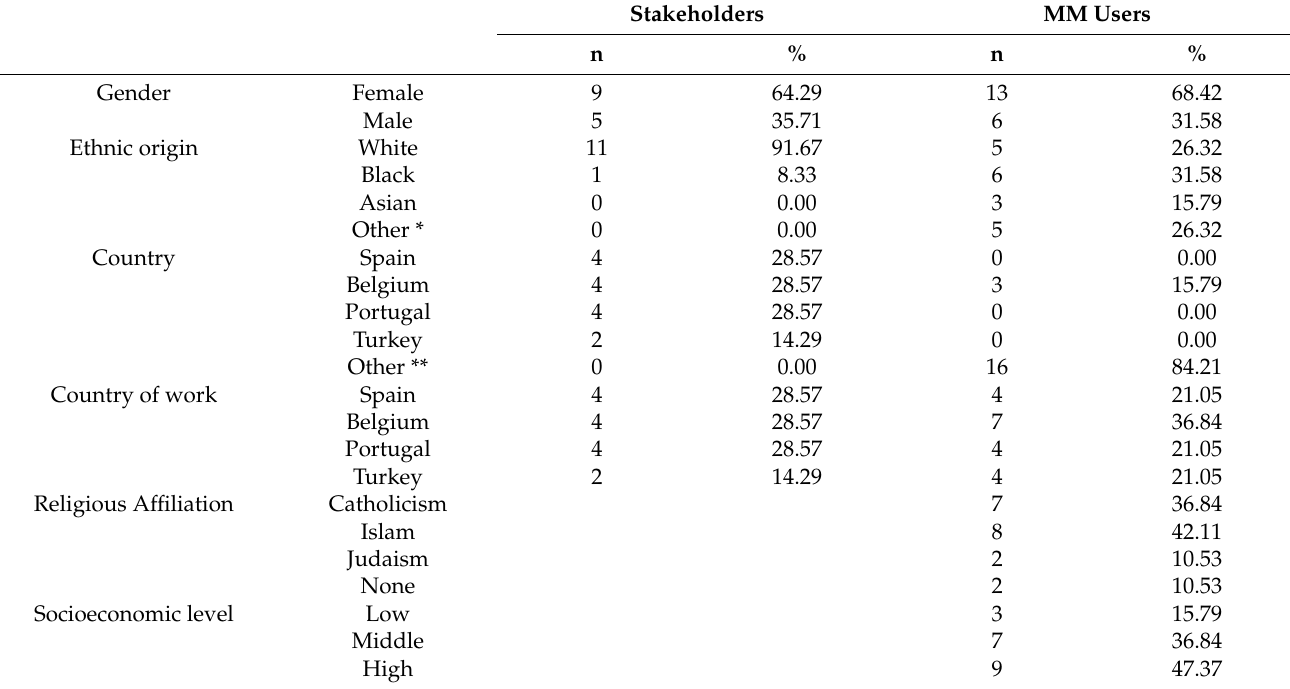
Table 3. Sociodemographic and cultural characteristics of the